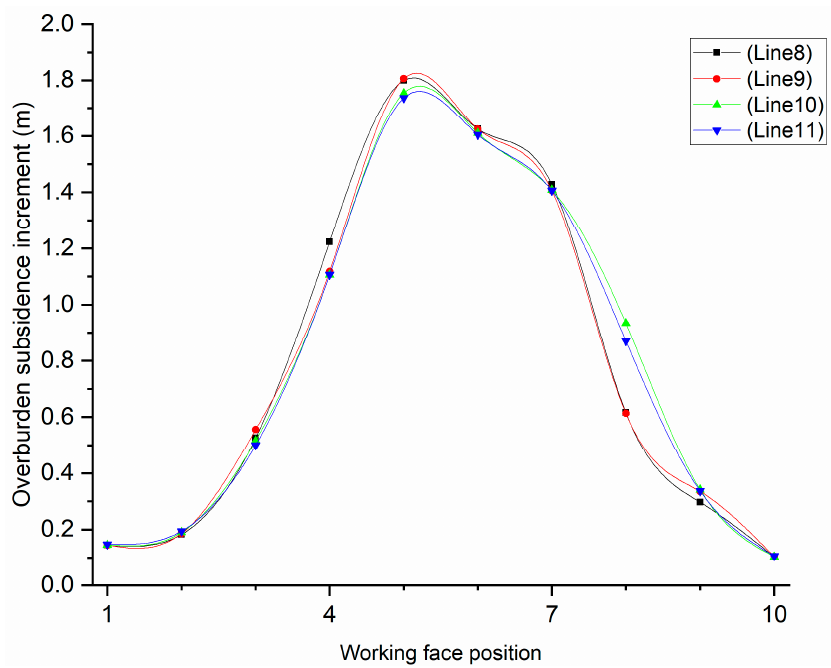
Figure 13. The secondary subsidence curve of coal seam No. 14-2 overlying strata of material simu- lation.